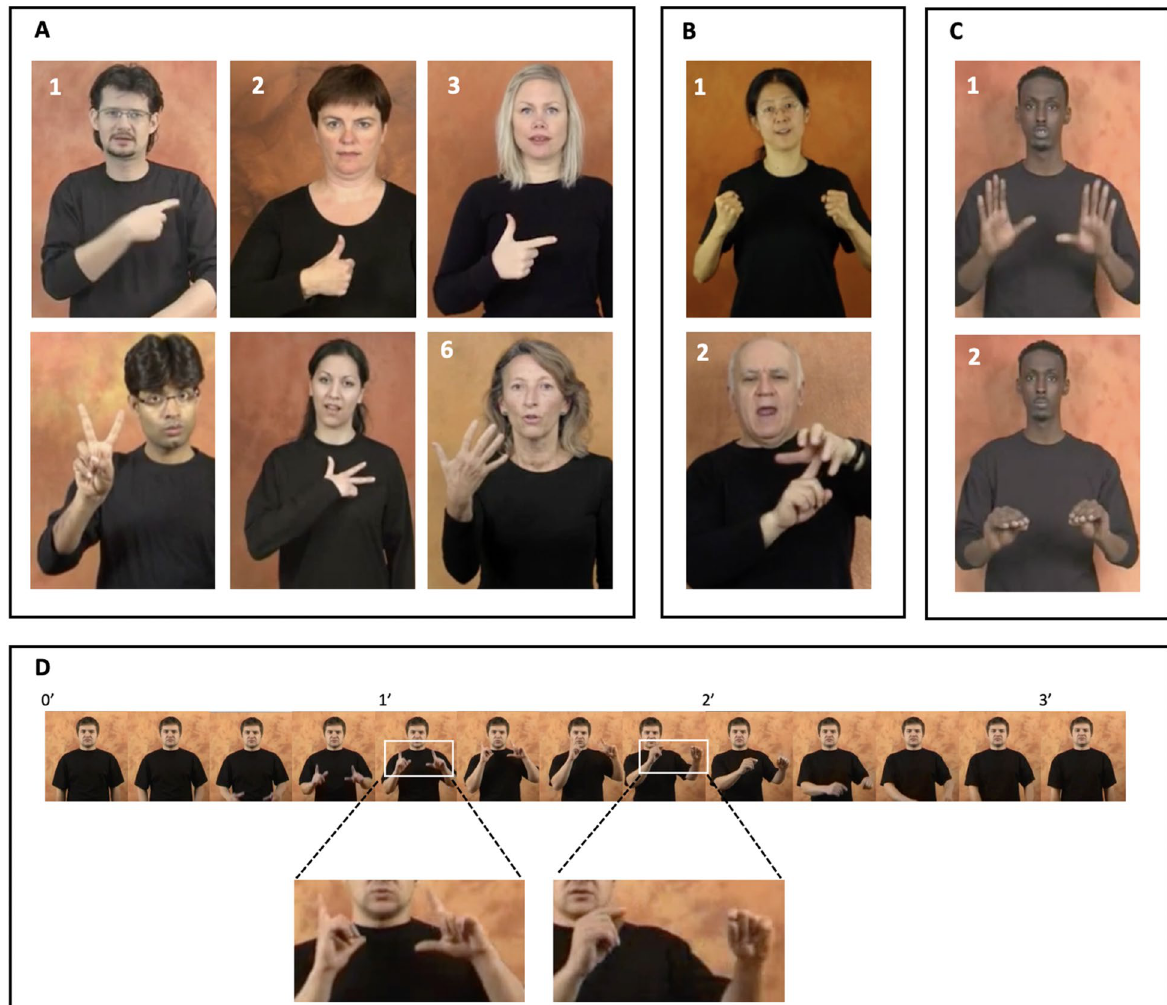
Figure 1. The signs in Panel ( A ) were made by the dominant hand and vary for handshape: in (1)–(5) the thumb or one or more fingers differ in shape from the other digits; in (6) the four fingers are identically shaped. The signs in Panel ( B ) were made by both hands; dominant and non-dominant hands are shaped identically (1) or differently (2). The sign in Panel ( C ) includes two handshapes, the first occurring at the beginning of the sign, the second at the end of it. Panel ( D ): frame-by-frame view of one of the videos we analyzed. The video showed one sign, and started and ended with the signer in resting position. Numbers correspond to recording time (in s). Enlarged pictures show the two configurations scored for this sign. Pictures of the signs are from the website Spread the Sign 55